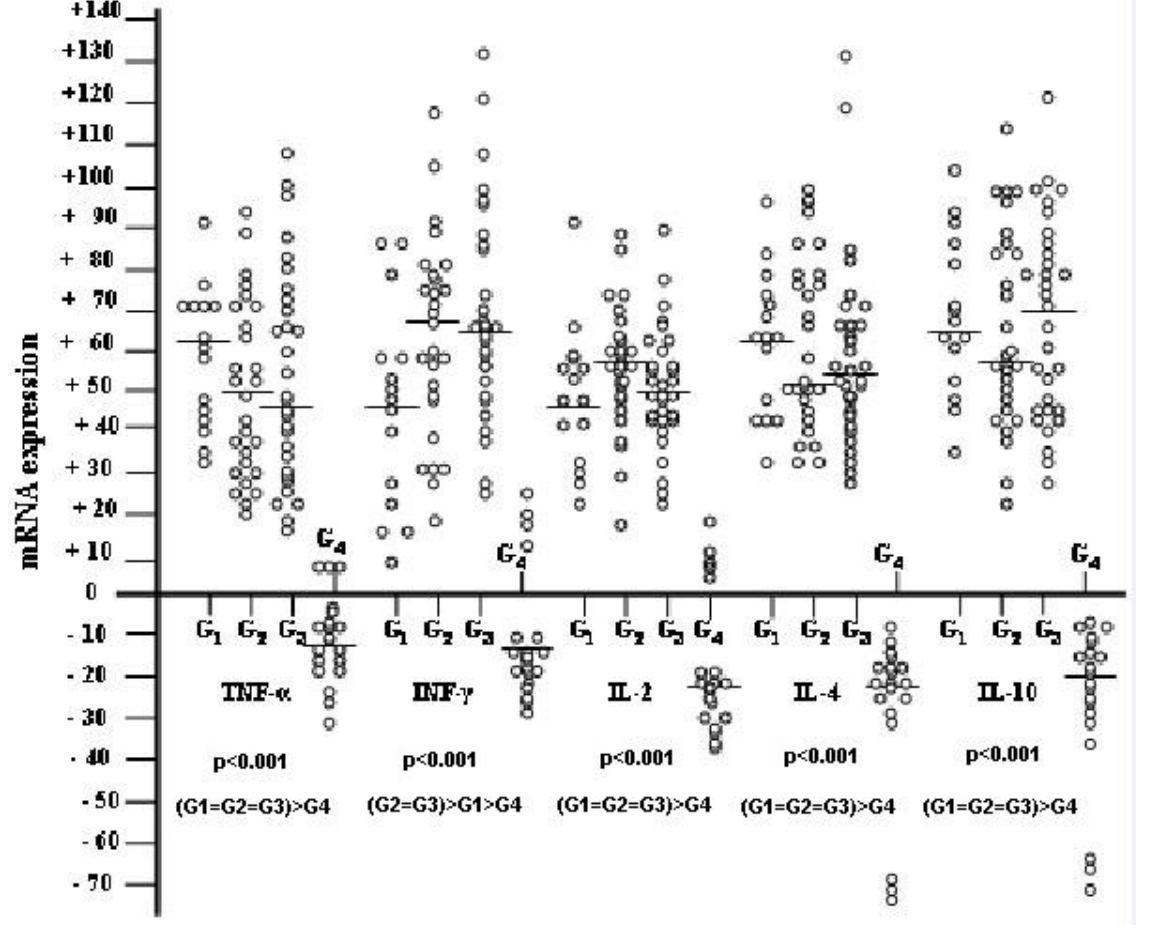
Figure 2. Distribution of mononuclear cell cytokine values per group (RT-PCR). = median G1:15 HIV-1 patients virgin to treatment; G2: 27 HIV-1 patients under HAART with detectable VL; G3: 31 HIV-1 patients under HAART with undetectable VL; G4: 20 normal blood donor